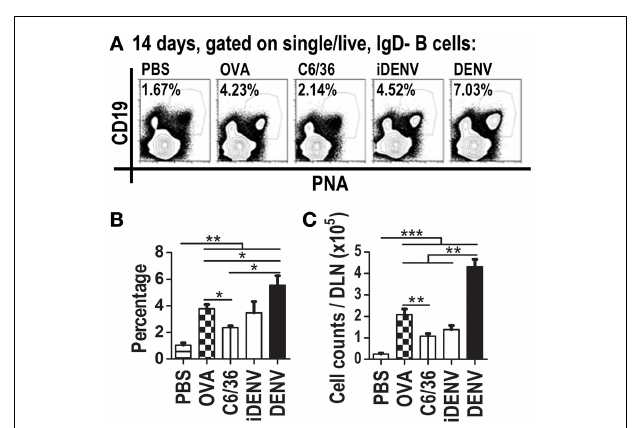
FIGURE 2 | Cutaneous DENV induces an increased number and size of GCs compared with control conditions . (A–L) DLNs from mice inoculated i.d. with DENV (A,E,I) , iDENV (B,F,J) , C6/36 (C,G,K) , or PBS (D,H,L) and collected at 7 (A–D) , 14 (E–H) , and 28 (I–L) days post-inoculation show an increased number and bigger GCs in animals infected with DENV compared with the other conditions. The limits of LN are indicated by dotted lines. Arrowheads indicate GCs, labeled in situ with PNA and revealed in blue-gray